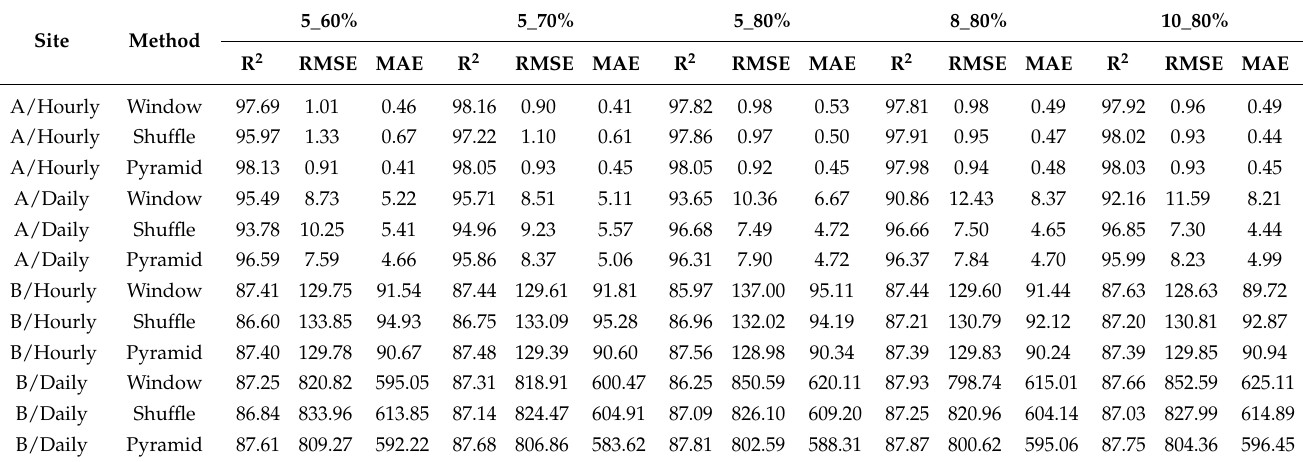
Table 10. Experimental results of comparing the partition length and subset